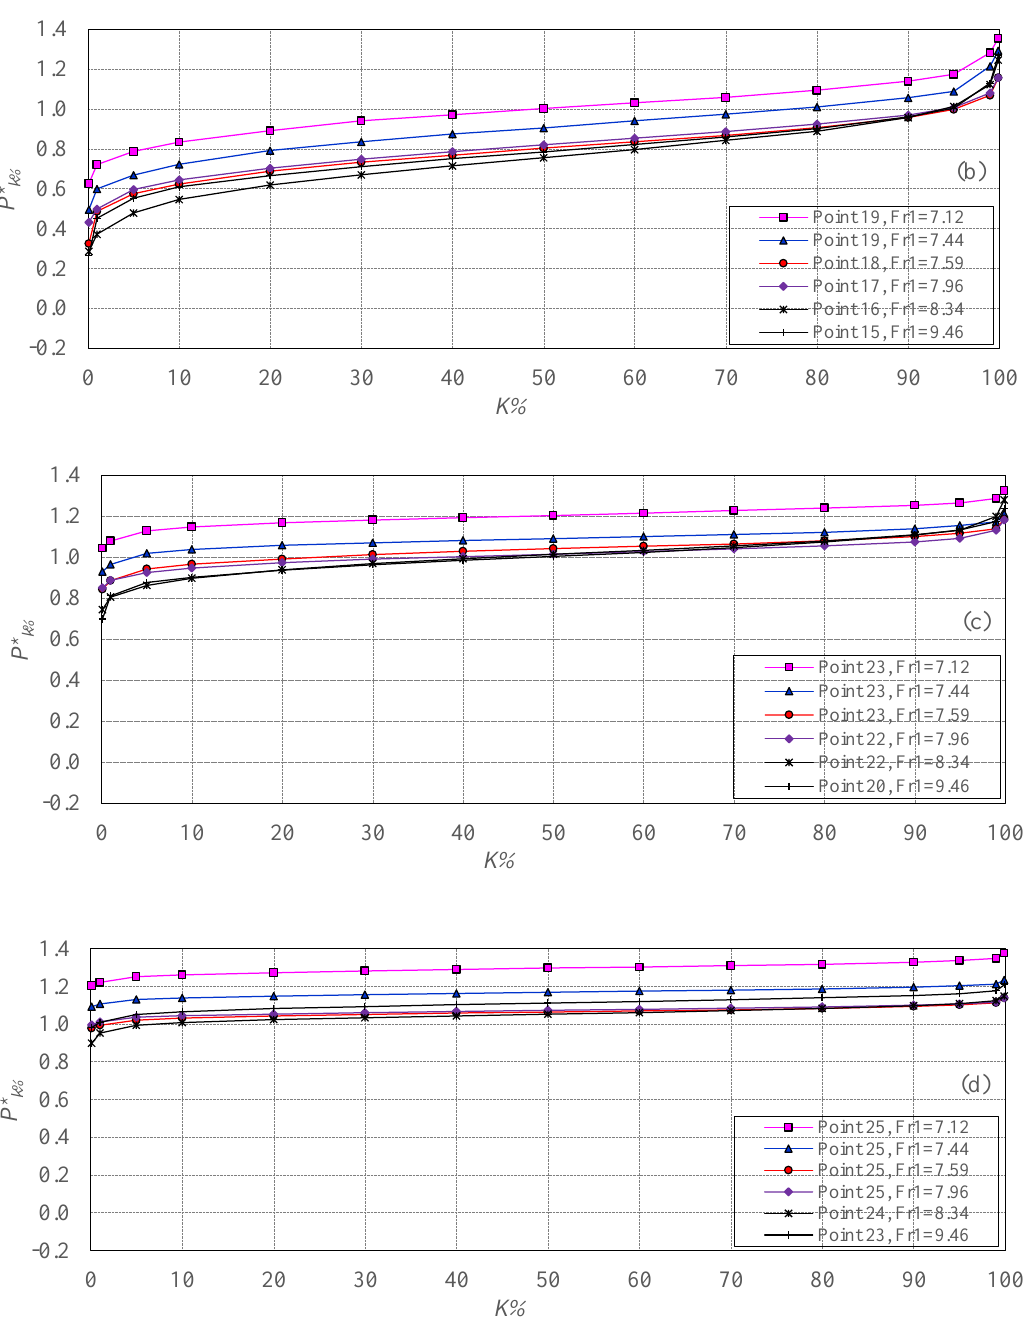
Figure 6. Cumulative pressure curves for P* k% related to the characteristic points of the hydraulic jump: ( a ) X* σ max , ( b ) X* d , ( c ) X* r , and ( d ) X* j .